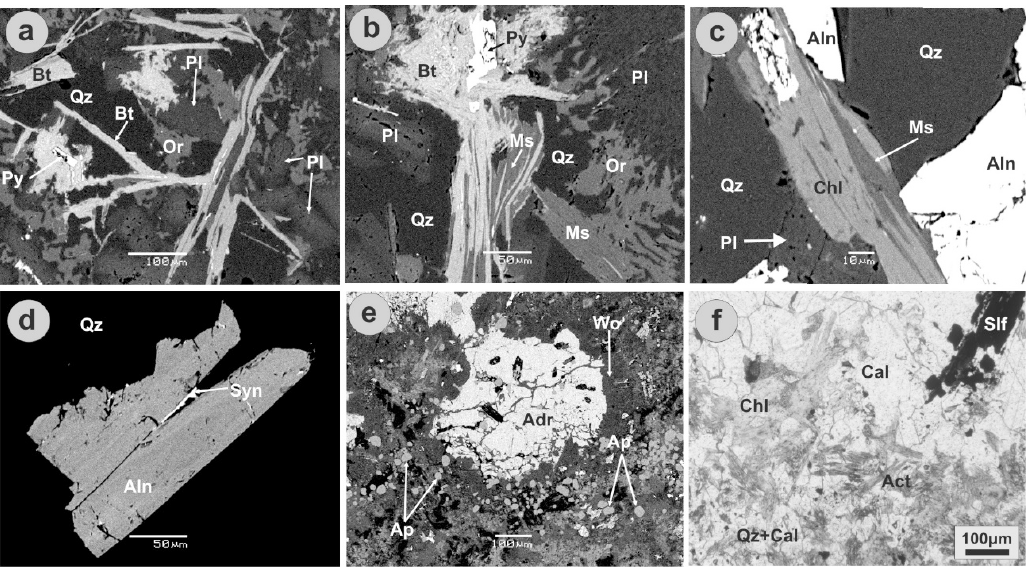
Figure 3. Photomicrographs of silicate assemblages in microgranite and associated skarn mineralization in the Serpieri deposit ( a – e ): SEM-BSE images; f: Transmitted, plain-polarized light microphotograph. ( a – d ) Plagioclase (Pl), biotite (Bt), orthoclase (Or), quartz (Qz), allanite-(Ce) (Aln), and synchysite-(Ce) (Syn) are accompanied by white mica (Ms), pyrite (Py), and chlorite (Chl) (microgranite porphyry); ( e ) andradite (Adr), wollastonite (Wo), and apatite (Ap) as part of the prograde skarn mineralogy in the Serpieri deposit; ( f ) quartz, calcite (Cal), chlorite and actinolite (Act) associated with sulfides (Slf) in the retrograde assemblage of the Serpieri skarn. Table 1. Major (in wt.%) and trace element content (in ppm) of microgranite porphyry from the Serpieri